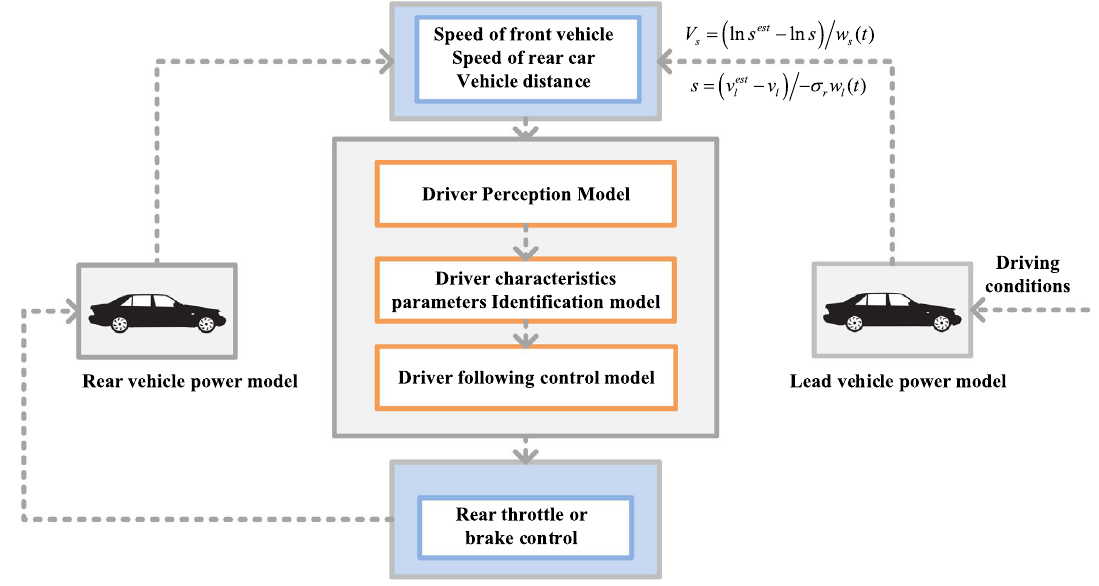
Figure 1. Example diagram of the driver’s longitudinal following behavior